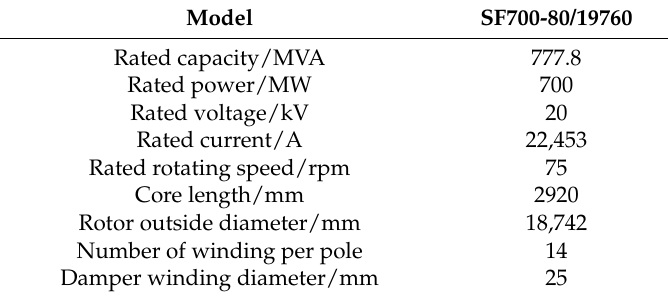
Table 1. Basic parameters of the hydro-generator.